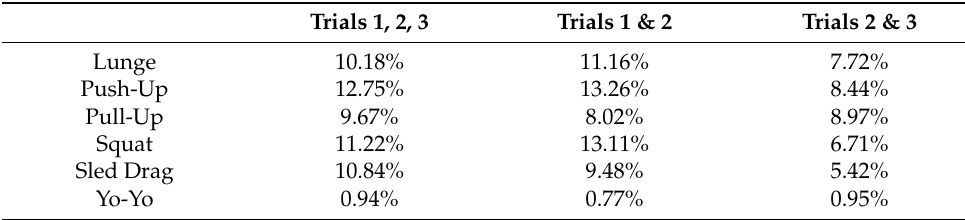
Table 3. Coefficient of variation across SORT battery trials ( n = 14).